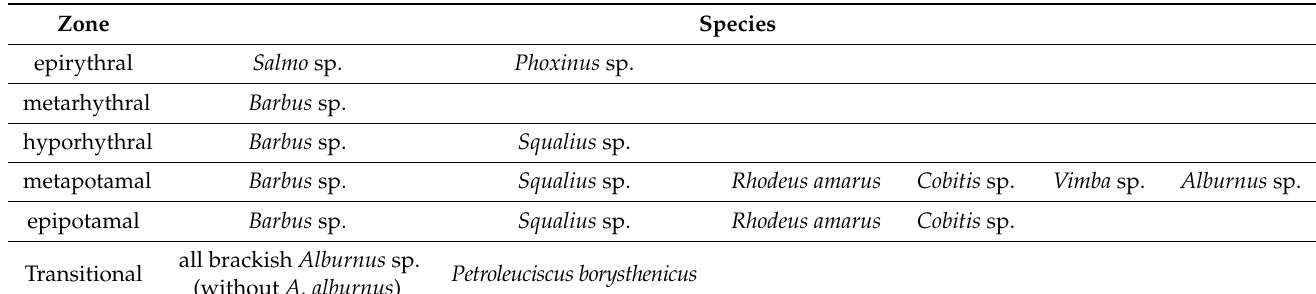
Table 2. Fish zonation according to Illies 1961 based on the established occurrence of freshwater fish species in